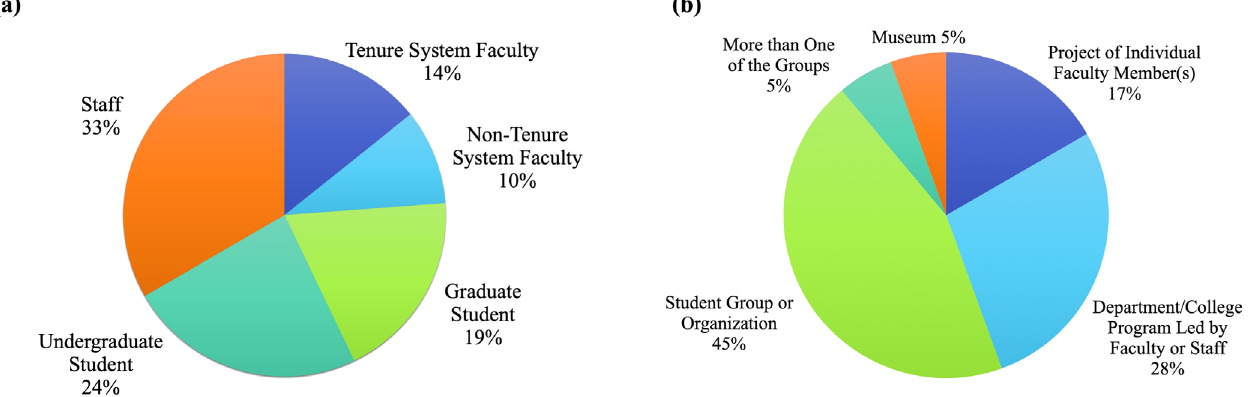
FIG. 3. (a) Distribution of the lead facilitator ’ s main job at their home institution. (b) The category breakdown of the person or group that is responsible for the